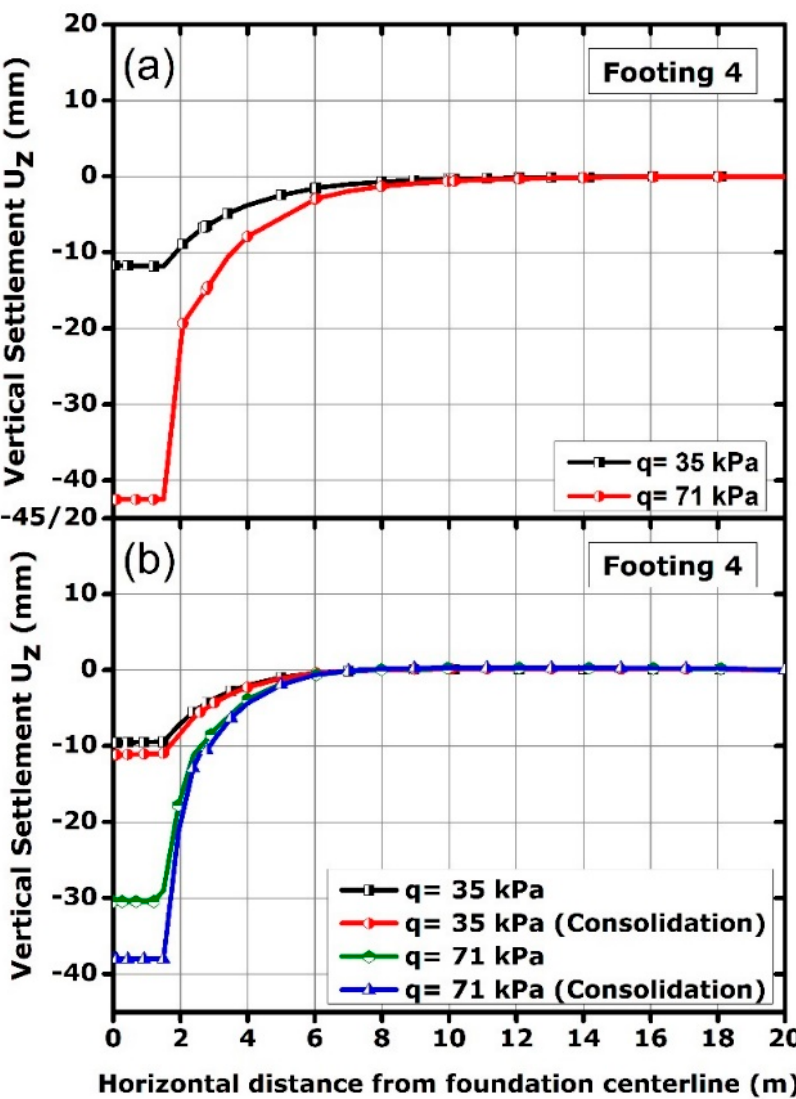
Figure 11. Influence of column length on the footing and ground surface settlement in ( a ) drained conditions; ( b ) undrained conditions—Footing 4.